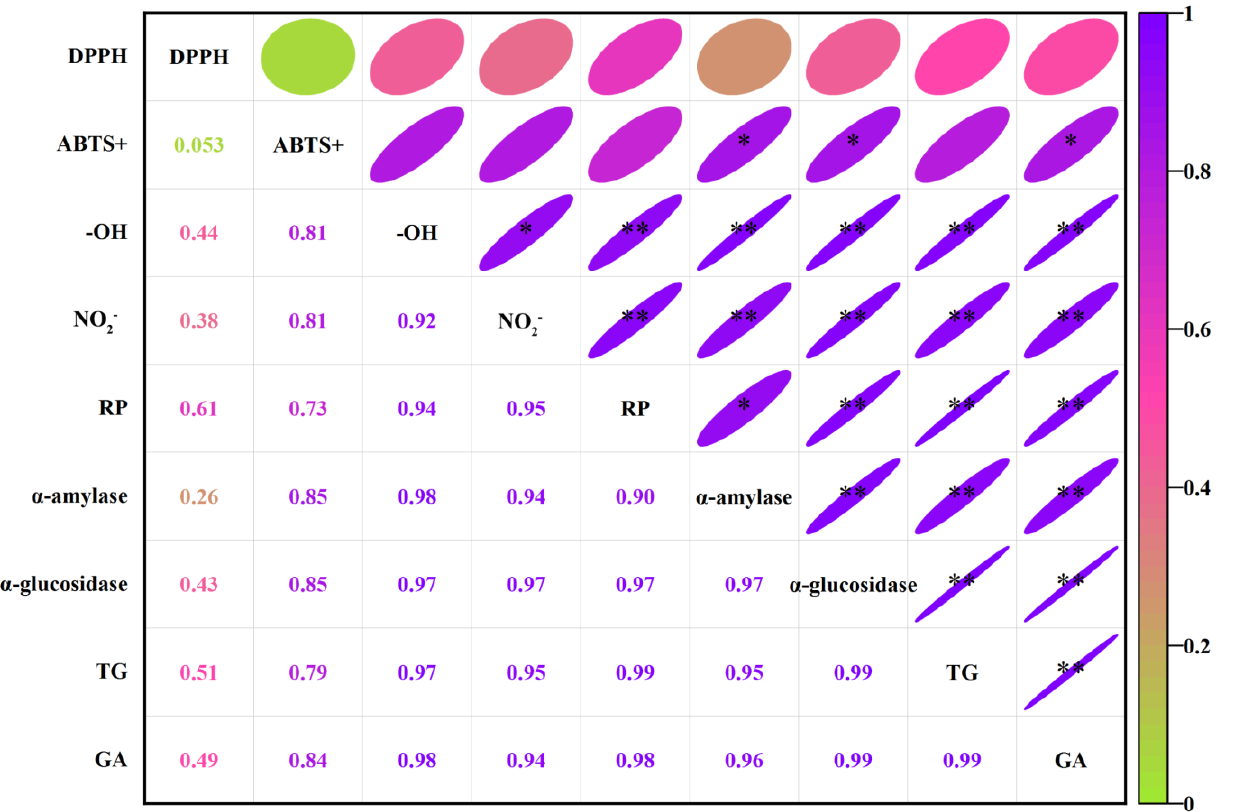
Figure 5. Correlation analysis of bio-activities based on the Pearson correlation (* p < 0.05, ** p < 0.01).